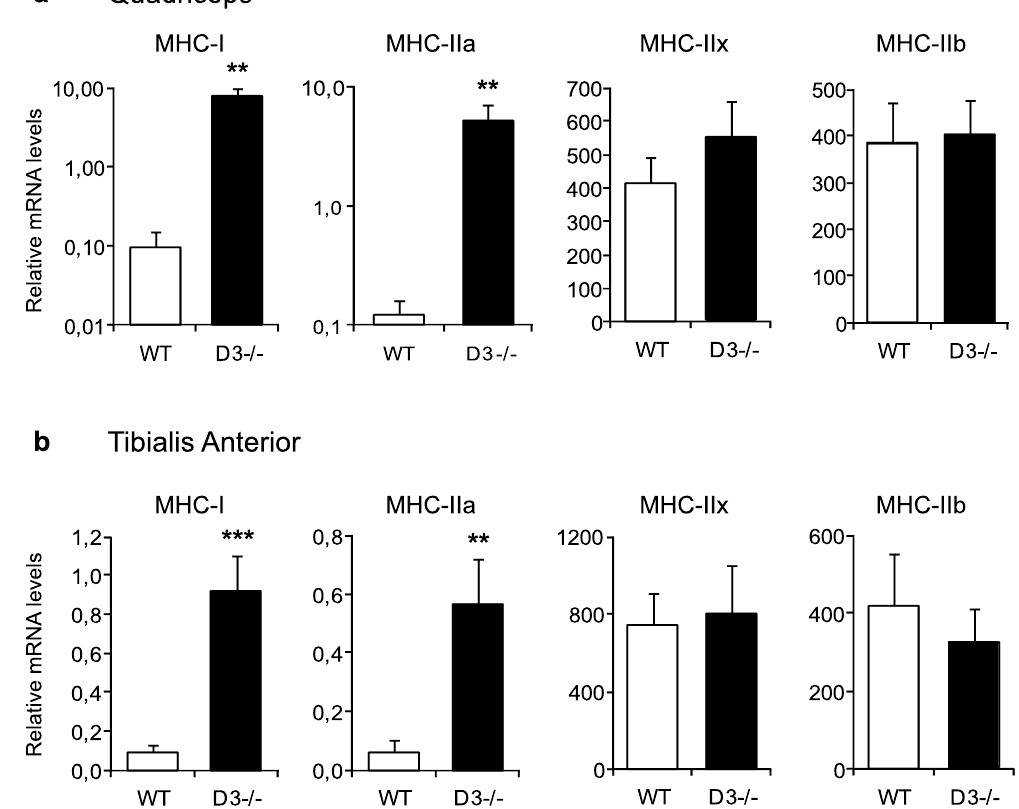
Figure 4. Cyclin D3 regulates the expression of slow, oxidative MHC isoforms. Transcripts coding for MHC-I ( Myh7 ), MHC-IIa ( Myh2 ), MHC-IIx ( Myh1 ) and MHC-IIb ( Myh4 ) were determined in quadriceps (panel a) and tibialis anterior (panel b) muscles of adult D3 − / − and WT mice by quantitative real-time PCR (n = 7 per group). mRNA levels are expressed relative to TBP (TATA binding protein) mRNA, used as endogenous control. Data are reported as means ± SEM. Statistical differences between WT and D3 − / − mice was assessed by two-tailed unpaired t-tests ( ** p < 0.01, *** p <